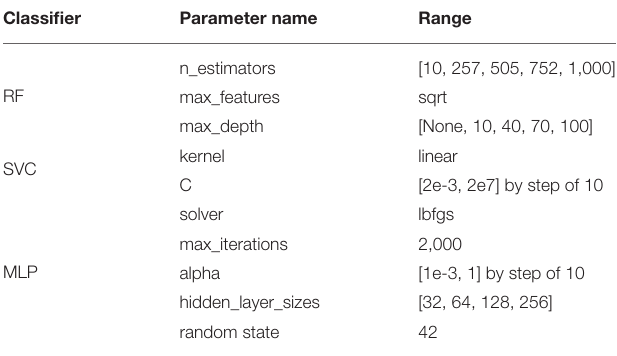
TABLE 4 | Final range of values tested for each hyperparameter (GridSearch 2